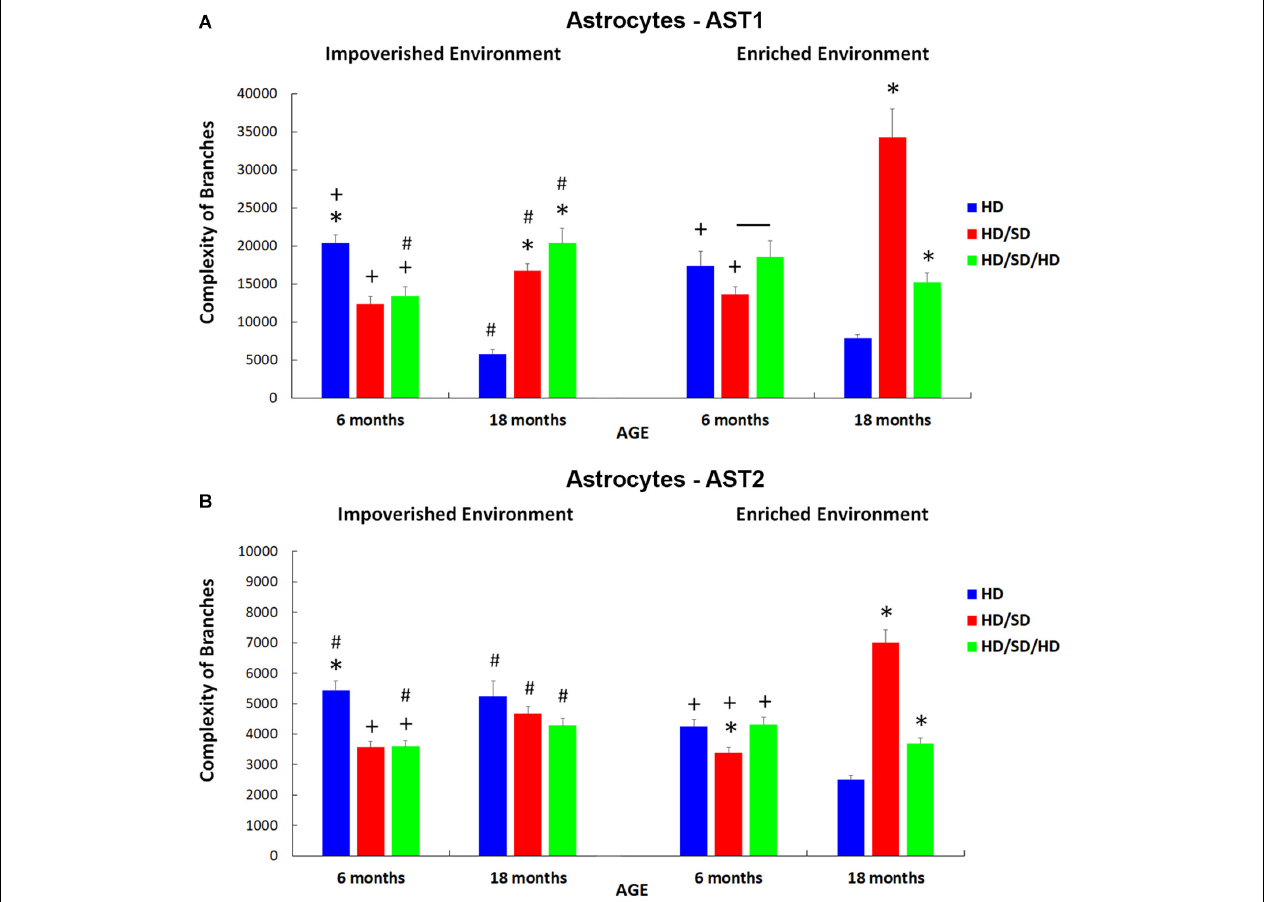
FIGURE 8 | Branch complexities of AST1 (A) and AST2 (B) for each diet regime (HD, HD/SD, and HD/SD/HD), and environment (impoverished and enriched), at 6 and 18 months of age. Results are expressed as mean + standard error. (*) Significant differences between all diet regimens; Connector lines indicate significant differences between dietary regimes; (+) Significant differences between ages; (#) Significant differences between environments. HD, hard diet/pellet food; SD, soft diet/powder food; AST1, astrocyte with high morphological complexity; AST2, astrocyte with low morphological